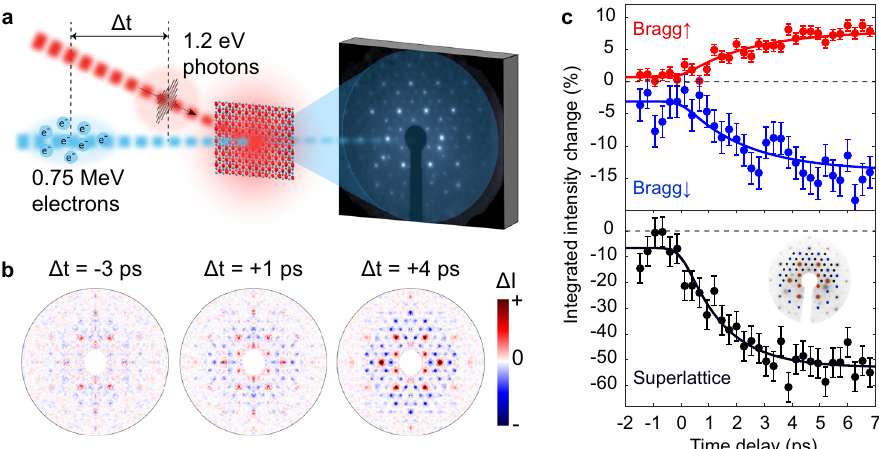
Fig. 2 Ultrafast electron diffraction of TaTe 2 . a Illustration of the optical pump, electron diffraction probe experiment. b Photo-induced changes in the diffraction patterns, for selected time delays. The colour scale gives the absolute diffracted intensity change ( Δ I ). The patterns have been symmetrised for visualisation purposes only. c Temporal evolution of the signals from the main lattice Bragg peaks, separately for the increasing and decreasing subsets, and of the low-temperature (LT) phase superlattice peaks. Solid lines: fi ts with an exponential function convolved with the time resolution of 0.75 ps, up to 7 ps delay time. The corresponding time constants are τ PLD = 1.44 ± 0.27 ps for the superlattice peaks and τ Bragg ↑ = 2.44 ± 0.81 ps and τ Bragg ↓ = 2.25 ± 1.34 ps for the main lattice peak subsets. Error bars in the data indicate standard error calculated using the distribution of laser-off signals compared to the mean laser-off signal over the course of the